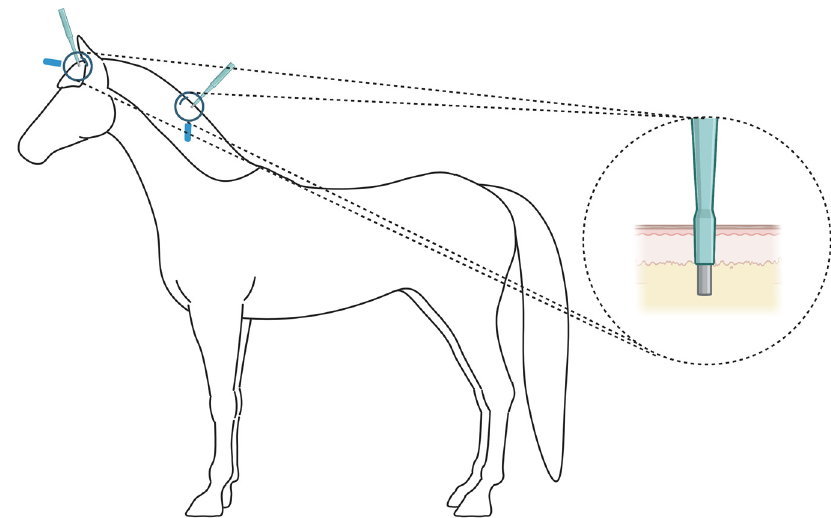
Figure 5. An illustration showing the location of the skin biopsies that were dissected from the forelock (between the ears) and the middle of the mane. The depth of the biopsy that included all the layers above the epidermal fat layer is illustrated. Plucked hair samples were obtained from the same locations. Figure created with BioRender.com.